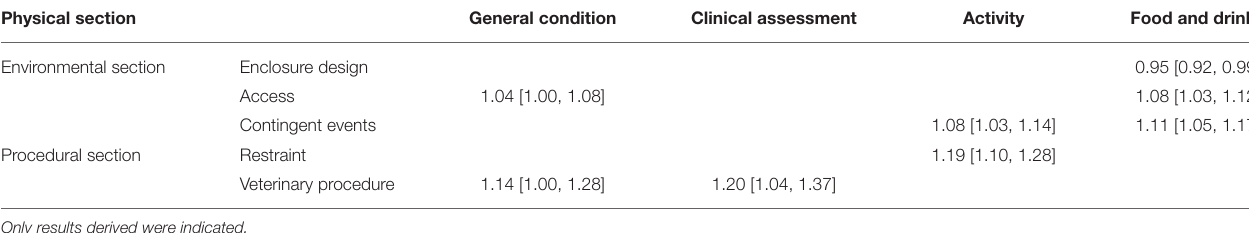
TABLE 6 | Estimates and 95% confidence intervals of odds ratio of physical AWAG factors, or any of environmental and procedural factors ( α = 0.05).